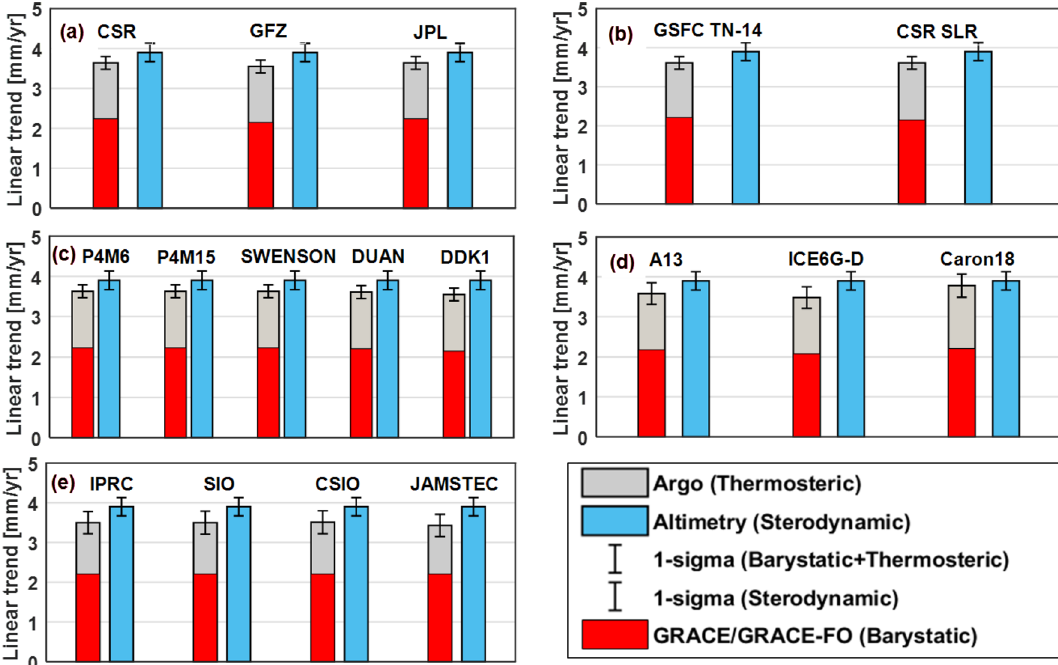
Figure 6. Linear trends of the global sea-level budget over January 2005 to December 2019 for Altimetry, Argo and GRACE/GRACE-FO observations over the sub-ensembles according to ( a ) processing center, ( b ) C 20 correction, ( c ) filtering method, ( d ) GIA correction and ( e ) Argo